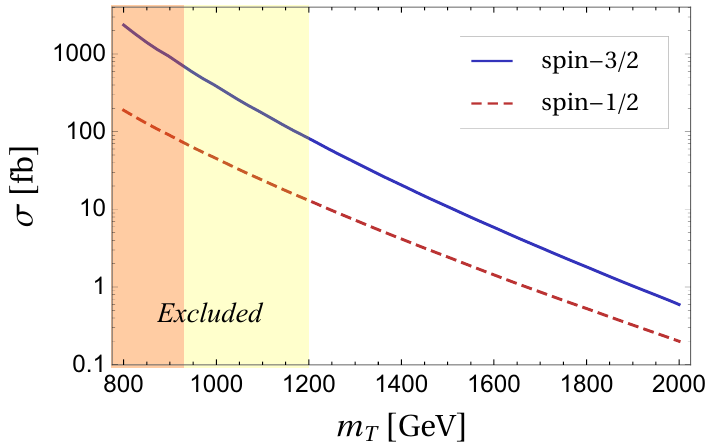
Figure 2 . Pair production cross sections of spin- 1 partners at leading order accuracy as a function of the top partner mass ( m T ) at the 14 TeV LHC. Yellow (red) shaded regions represents the spin- 3 data at 95% C.L. with 35.9 fb (cid:0) 1